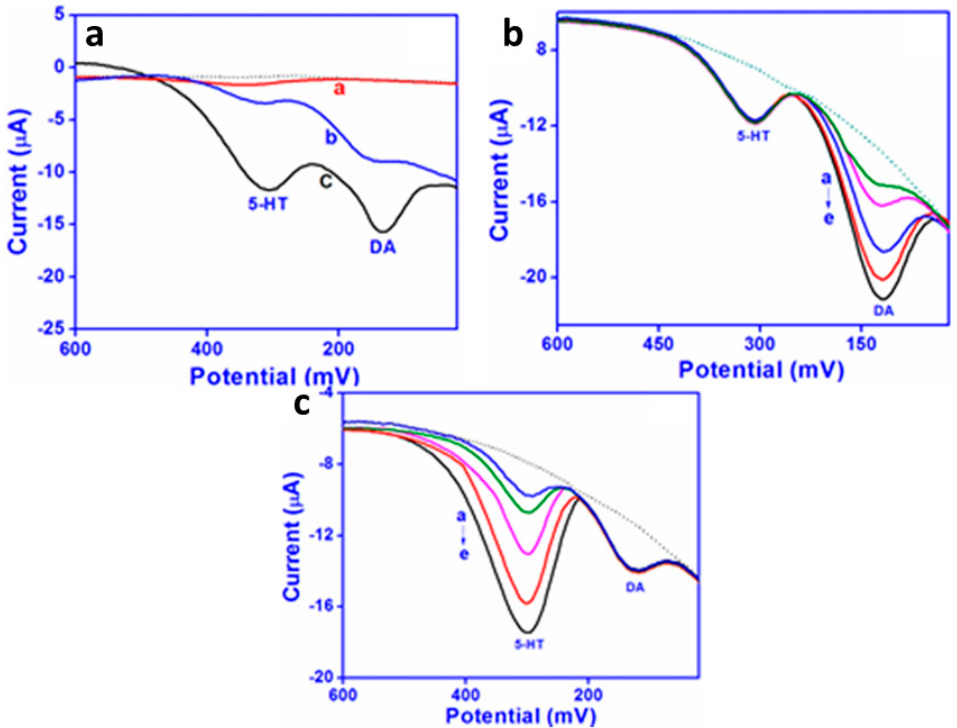
Figure 13. ( a ) A comparison of square wave voltammograms of 50 µ M each of dopamine (DA) and serotonin (5-HT) on bare SPC (curve a), graphene-coated SPC (curve b), and CP / graphene-coated SPC (curve c) in phosphate bu ff er at pH 7.2 at a scan rate of 100 mV s − 1 using an Ag / AgCl reference electrode. ( b ) Square wave voltammetry in pH 7.2 phosphate bu ff er with 5-HT concentration held constant at 50 µ M while DA concentration was increased from 15 to 80 µ M. ( c ) Square wave voltammetry in a pH 7.2 phosphate bu ff er with the DA concentration held constant at 20 µ M while the 5-HT